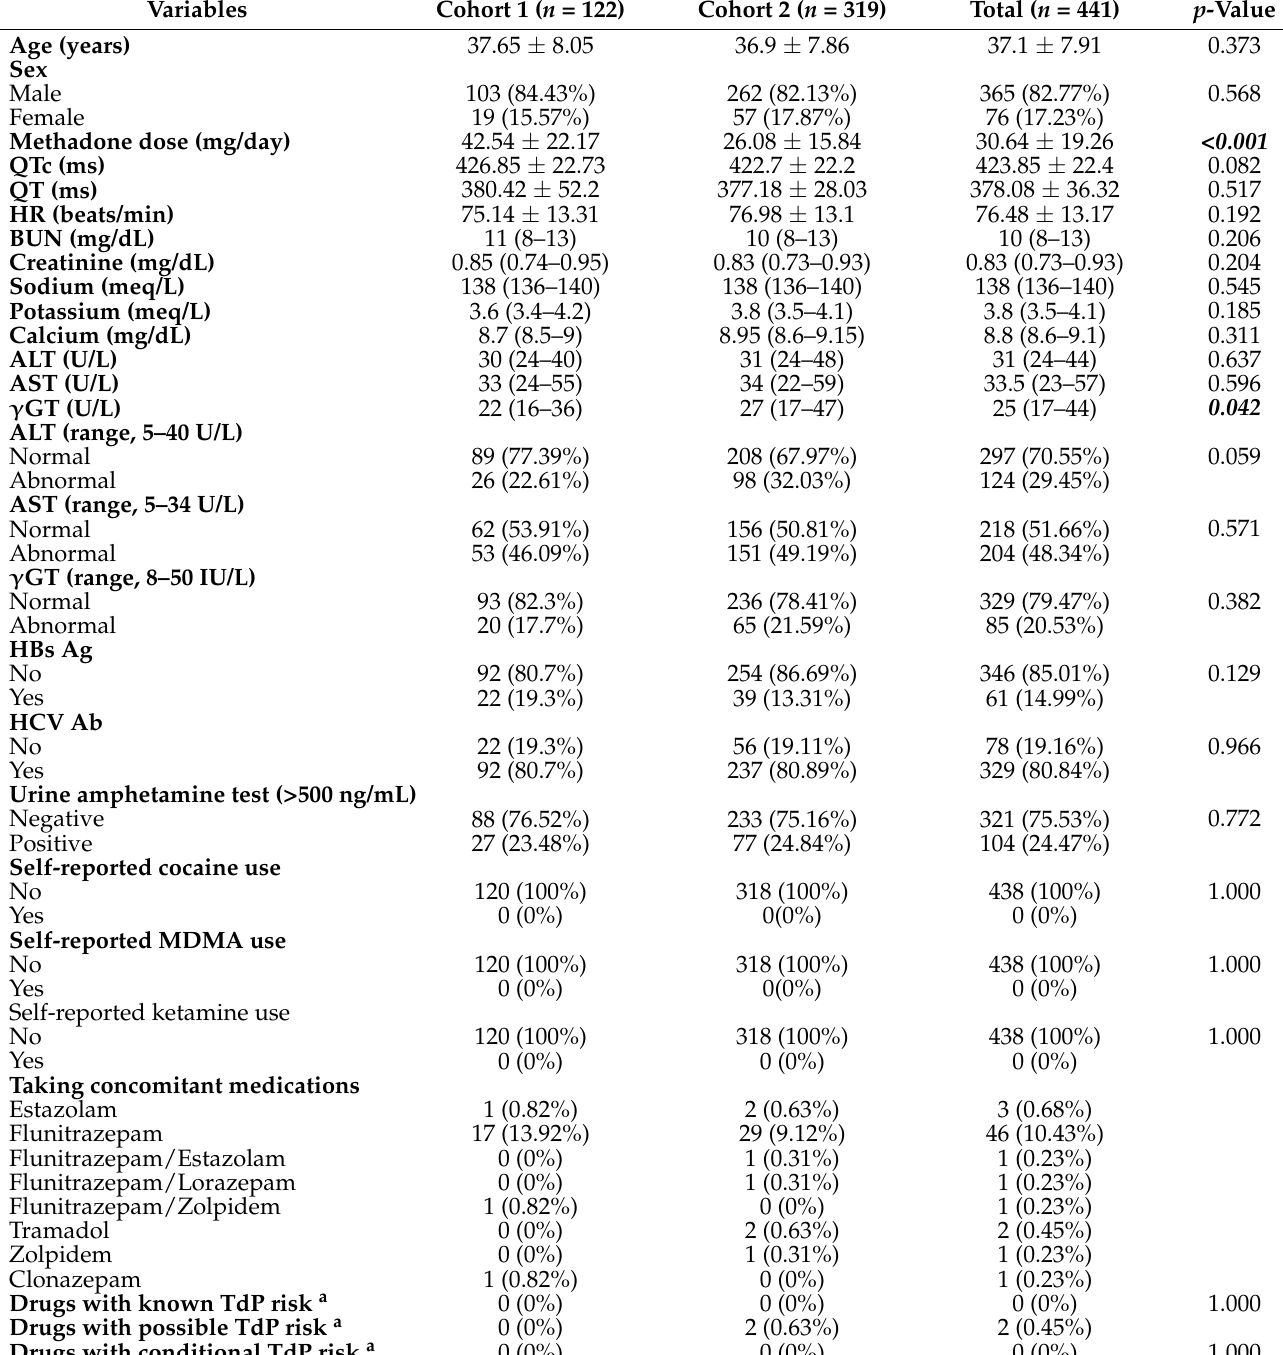
Table 1. Demographics and clinical data of study